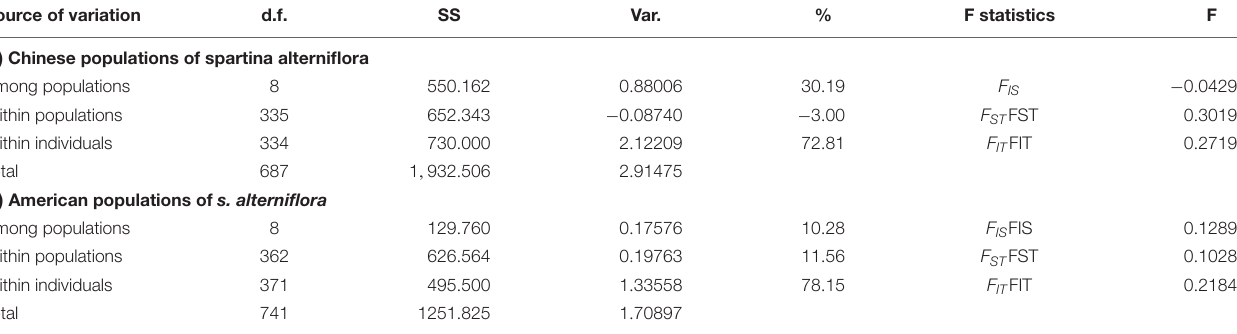
TABLE 4 | Analysis of molecular variance showing degrees of freedom (d.f.), sum of squares (SS), variance components (Var.), percentage of variances (%). Source of variation d.f. SS Var. % F statistics F